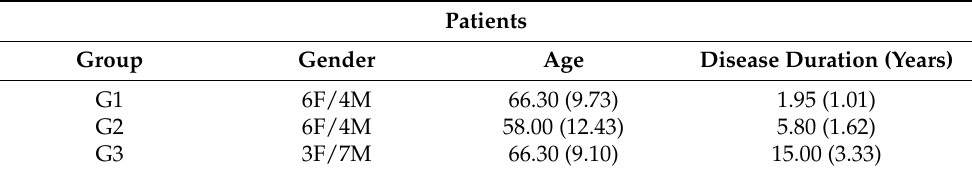
Table 5. Groups of patients: gender, mean, and SD values for age and disease